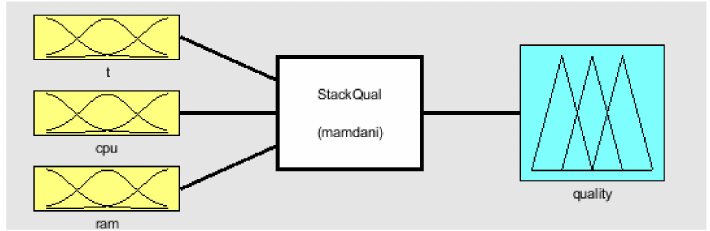
Figure A1. Structure of fuzzy inference